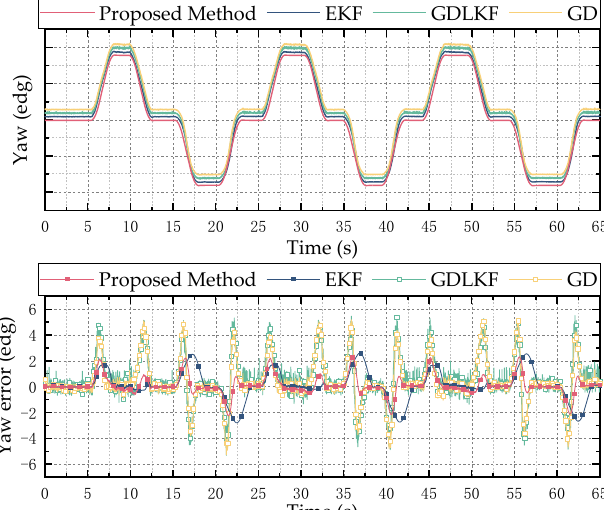
Figure 12. Hardware-in-the-loop simulation test results of roll angle. The above is a comparison of the estimation results of different methods, and the bottom is the error between the estimated value of different methods and the reference value.